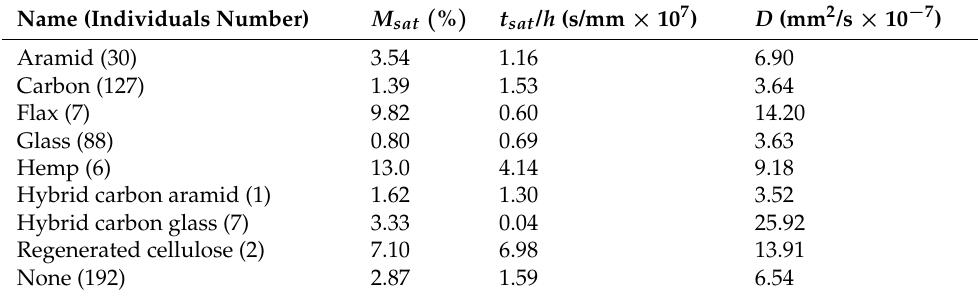
Table 4. Medians of M sat , t sat / h and D as a function of the reinforcement type. “None” refers to a neat resin, without reinforcement. Entire box plots are available as Supplementary Materials (Figures